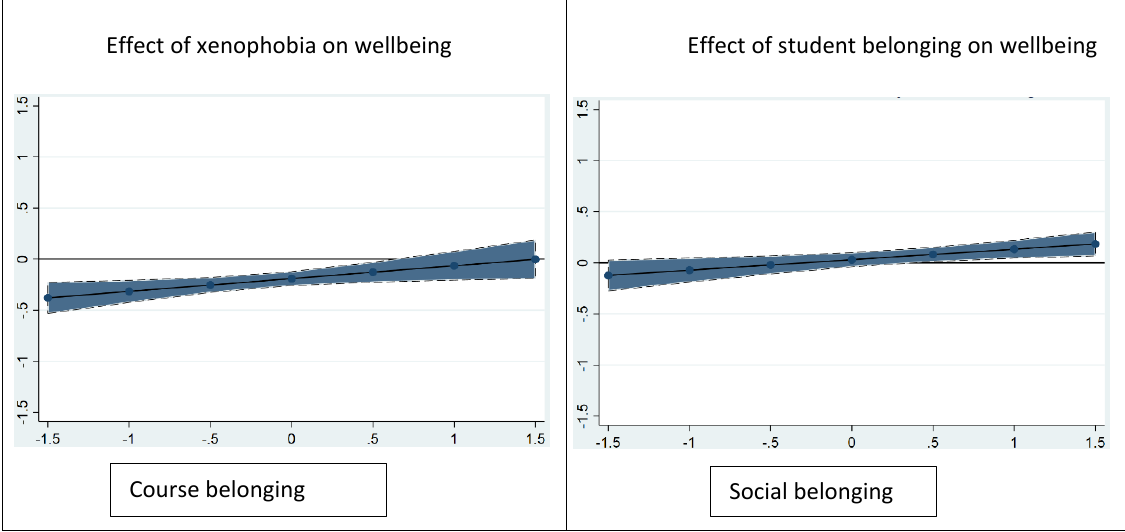
Buffer Effect of Course Belonging and Boost Effect of Social Belonging Effect of xenophobia on wellbeing Effect of student belonging on